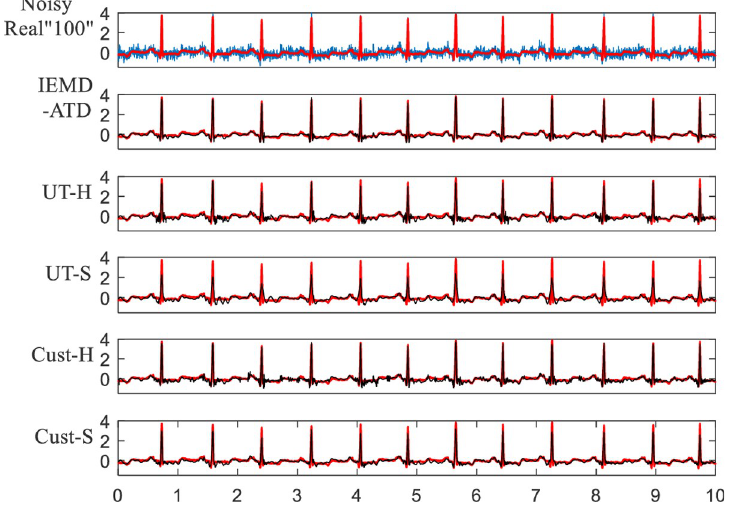
Fig 15. Waveforms of denoised ECG for real “100” with WN at 5 dB for the 5 denoising